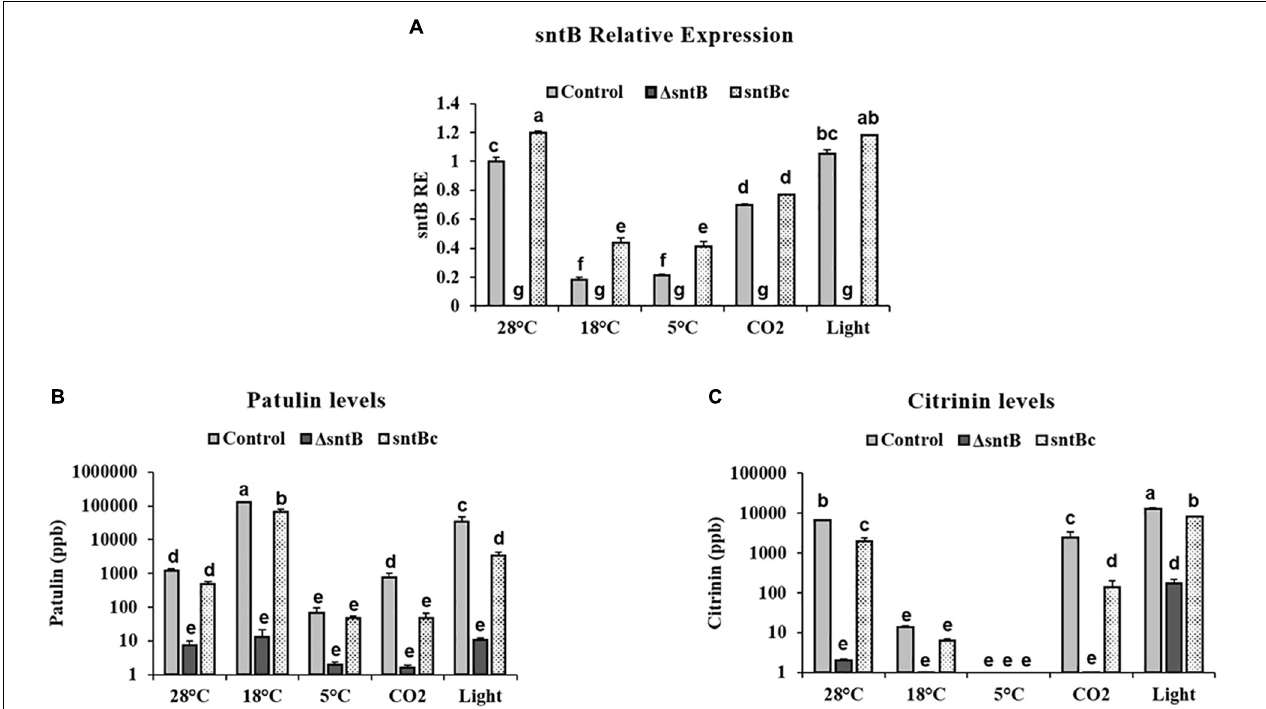
FIGURE 4 | Effect of abiotic factors on sntB expression and mycotoxin accumulation. The three Penicillium strains (control, (cid:49) sntB , and sntB c) were grown on YES agar media at 28 ◦ C for 48h in the dark and then subjected to different treatment conditions for additional 48 h. Control – 28 ◦ C incubation in the dark; 18–18 ◦ C incubation in the dark; 5–5 ◦ C incubation in the dark; light – 28 ◦ C incubation under continuous white fluorescent lighting; CO 2 – 28 ◦ C incubation at 20% CO 2 in the dark. (A) Total RNA was extracted and the relative expression of sntB was evaluated. (B) Patulin and (C) citrinin were extracted and subjected to HPLC analysis. Each strain was inoculated with 3 reps. One-way ANOVA differences were considered significant when p < 0.05. Different letters above the columns indicate statistically significant differences between the strains as determined using Tukey’s single-step multiple comparison